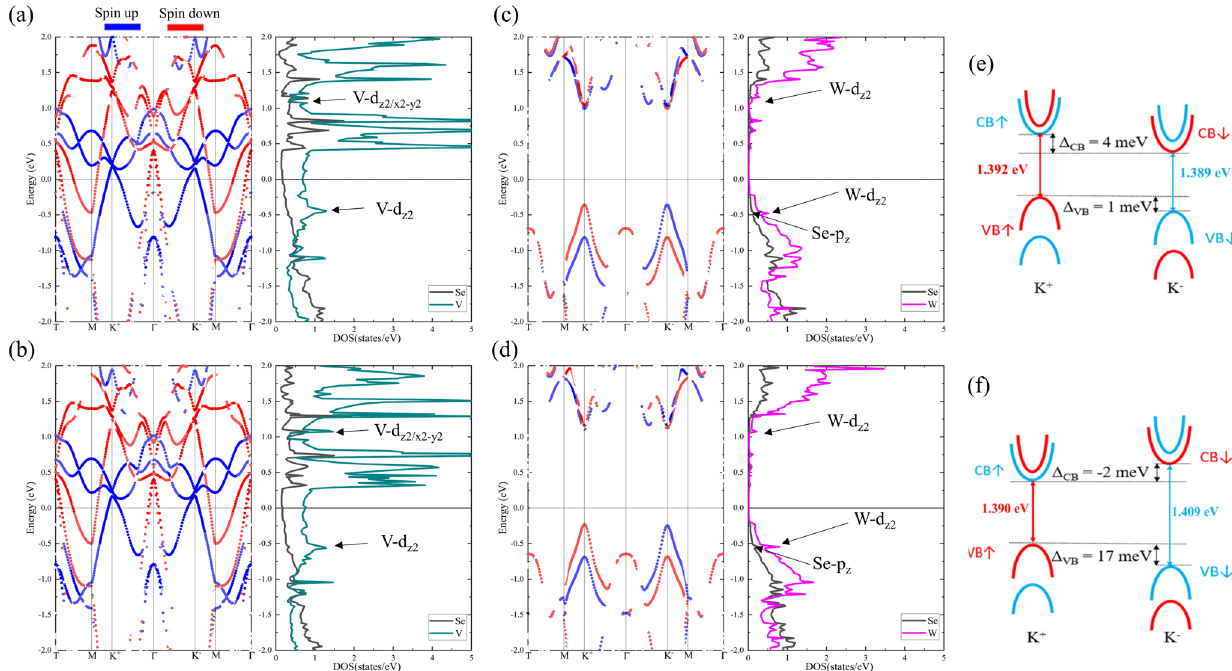
Fig. 3 Electronic structure of the WSe 2 /VSe 2 heterostructure. Projected band structure including SOC and density of states (PDOS) of the WSe 2 /VSe 2 heterostructure with contribution from the VSe 2 layer in a C-I stacking, b C-II stacking, and contribution from the WSe 2 layer in c C-I stacking and d C-II stacking. Blue and red lines represent the majority spin (spin-up) and minority spin (spin-down) band contributions. Band alignment diagram at K + and K − valleys of the WSe 2 layer in e C-I stacking and f C-II